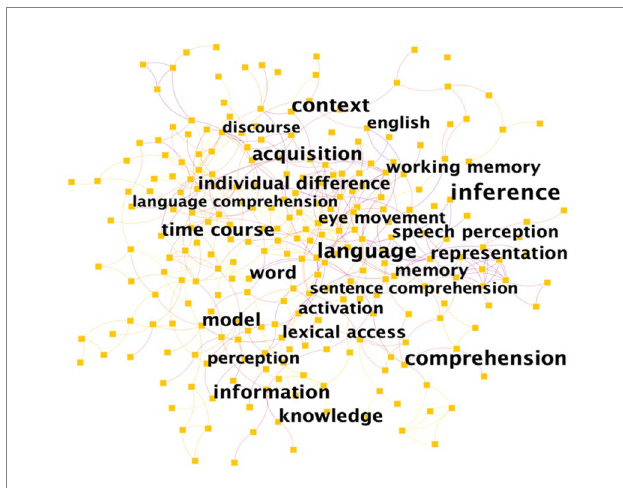
FIGURE 5 Top 23 most frequent co-occurring keywords in lexical inferencing research.